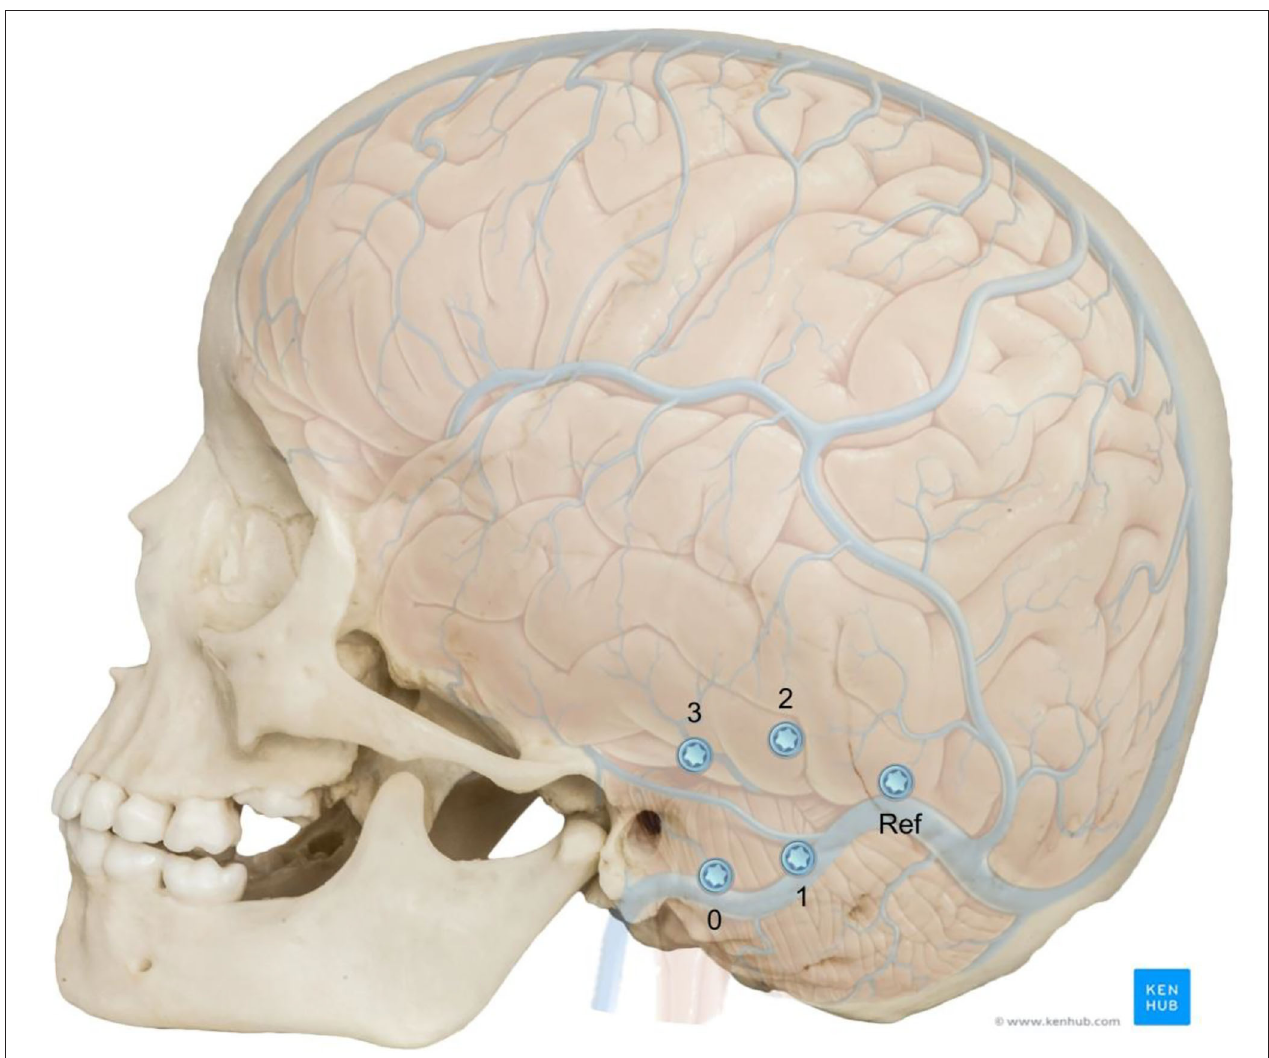
FIGURE 2 | Adjusted position of the fiducial screws relative to the neurovascular anatomy in a 5 year old skull. The screws positions were numbered for better identification and the reference screw position is shown. Image adapted from sources: © Bone Clones (www.boneclones.com); © Kenhub (https://www.kenhub.com/ en/library/anatomy/veins-of-the-brain), Illustrator: P.